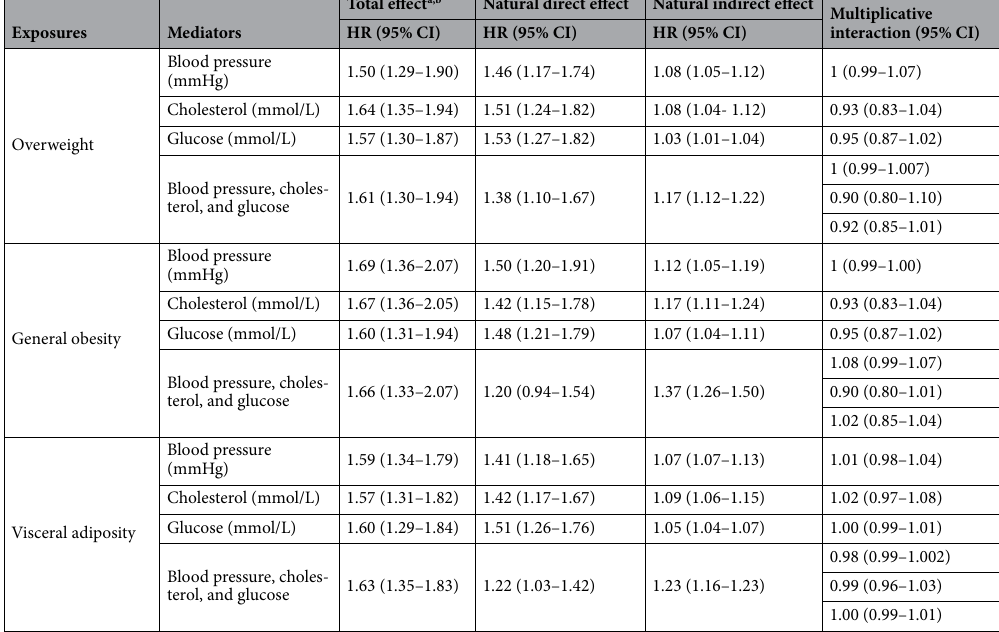
Table 5. Total, direct, and indirect effects of overweight and adiposity on cardiovascular diseases (CVDs) using a parametric method considering exposure-mediator interaction. MI body mass index; CI confidence interval; HR hazard ratio; WC waist circumference. a Compared with normal-weight participants for general adiposity and WC < 90 cm as a reference for central adiposity. b All models were adjusted for age, gender, smoking, physical activity level, educational status, and family history of CVDs. c The direct, indirect, and total effects were estimated for each bootstrap